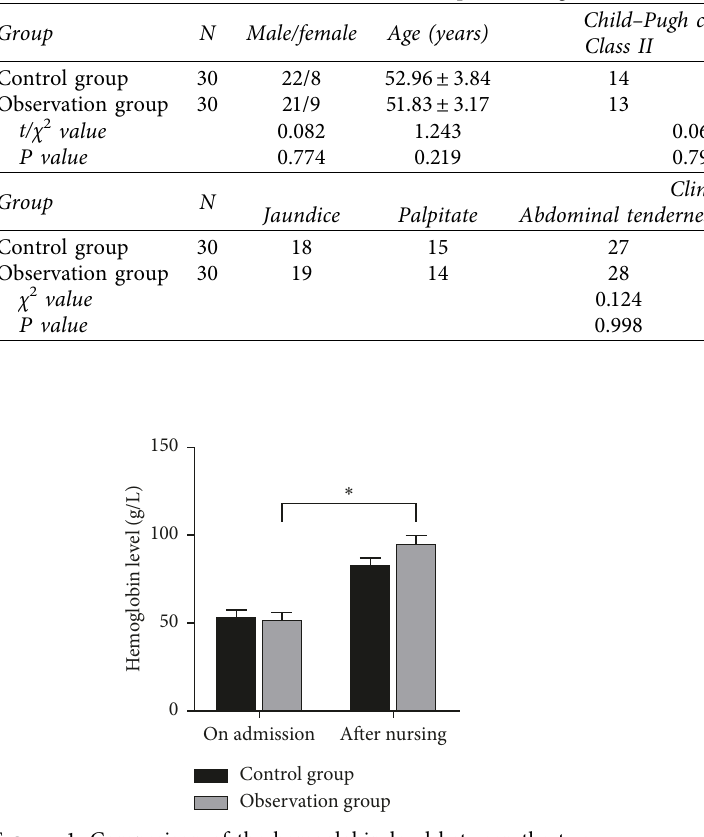
Figure 1: Comparison of the hemoglobin level between the two groups. Note: compared with the control group,